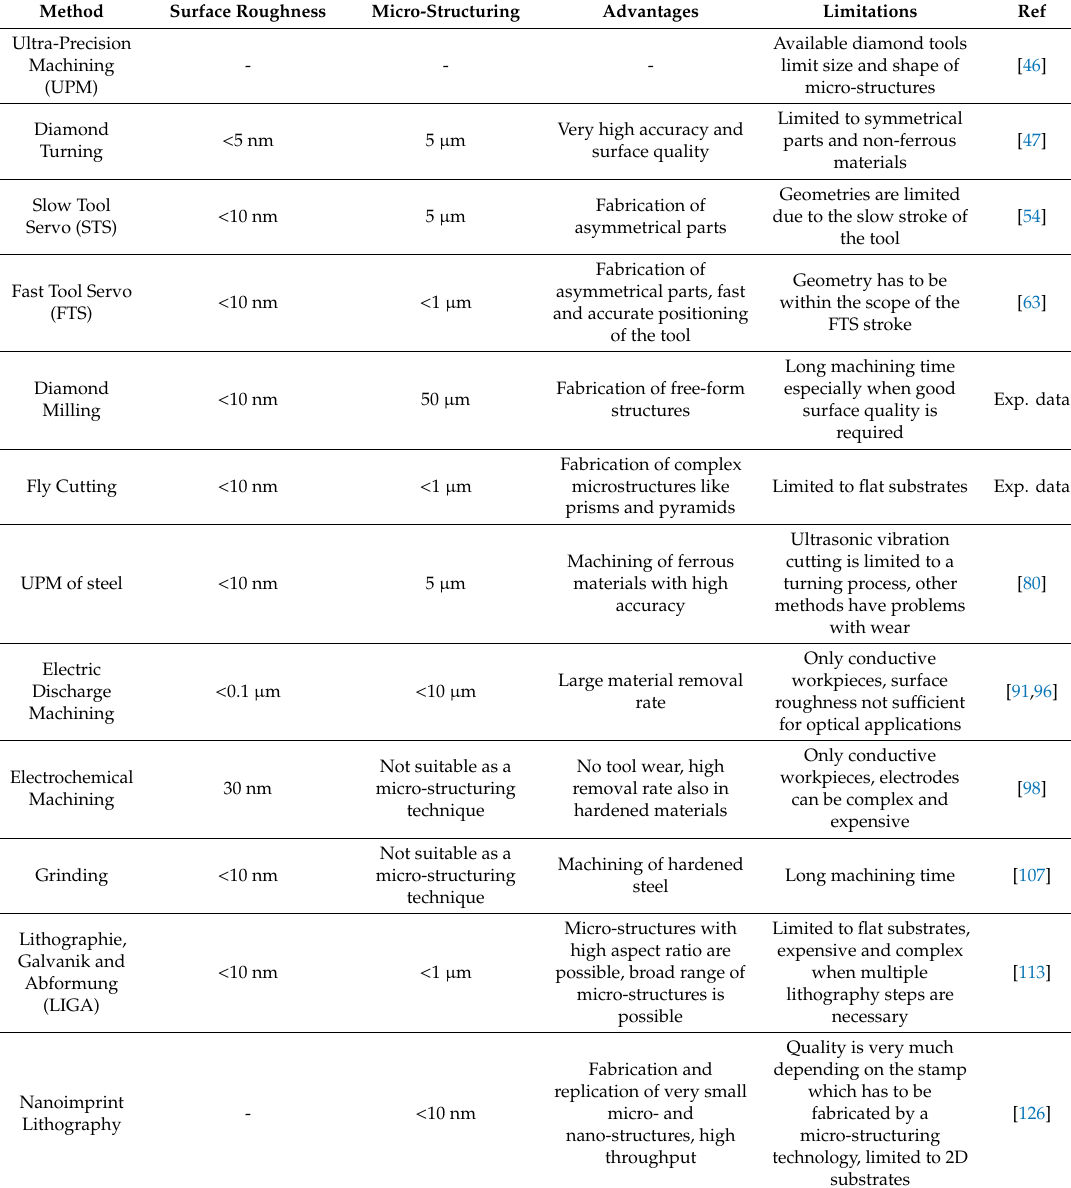
Table 1. Overview of technologies to fabricate optical mold inserts and micro-structured